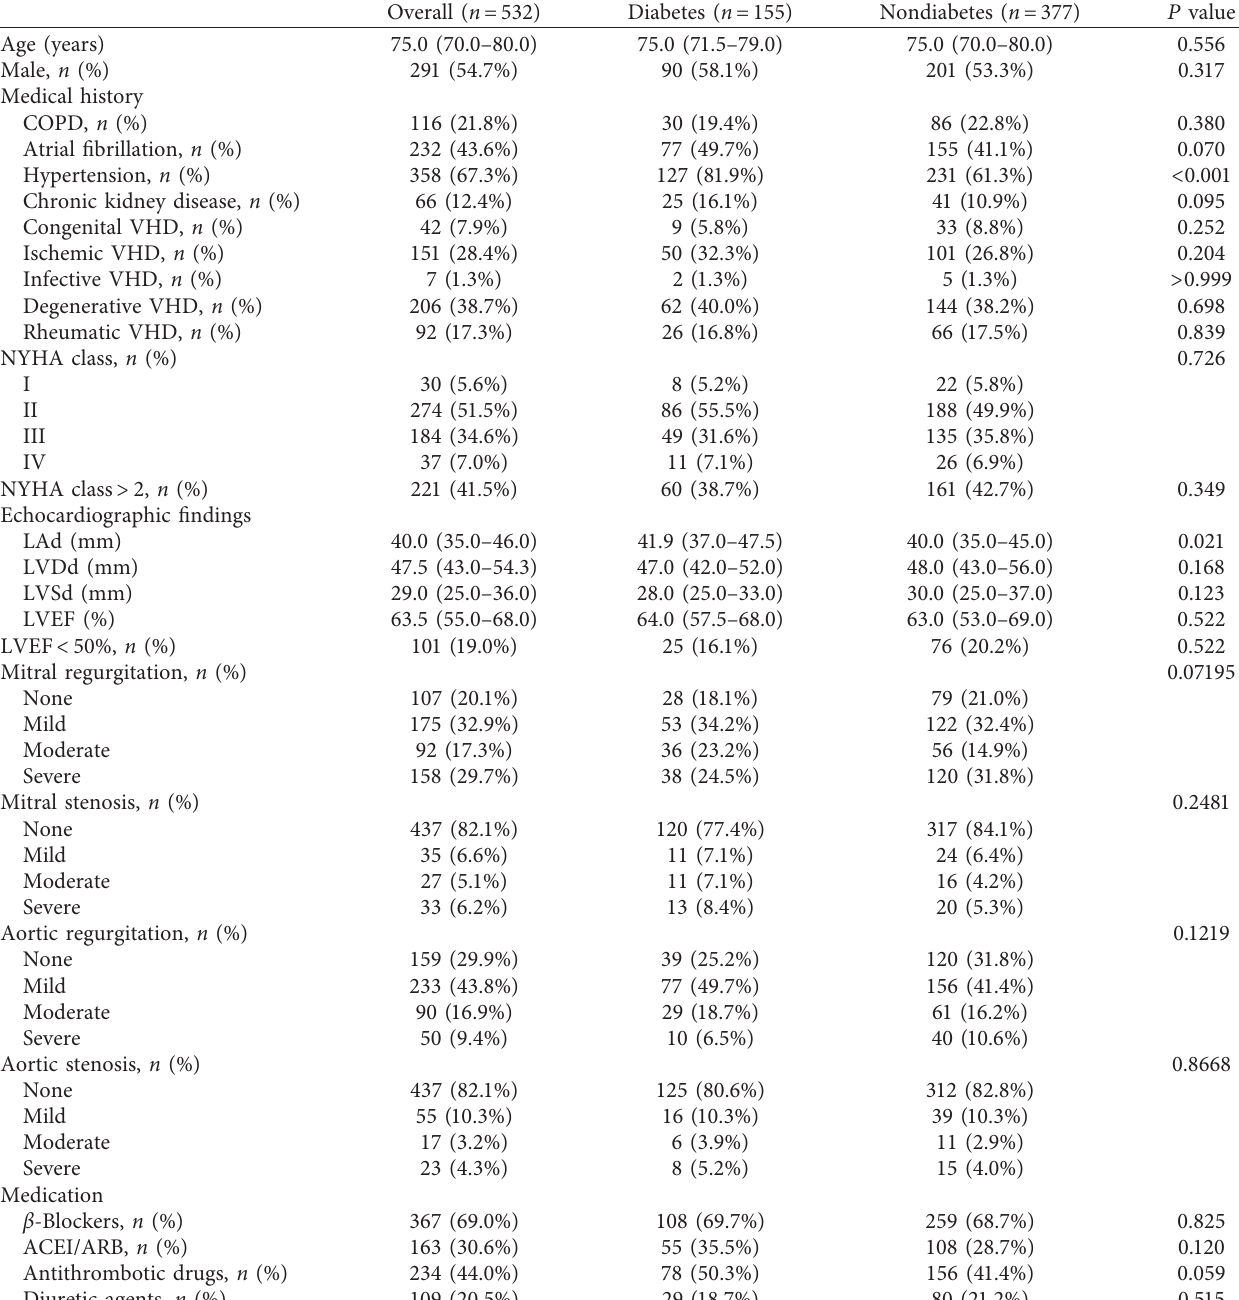
Table 1: Baseline characteristics stratified by presence of diabetes mellitus in elderly VHD